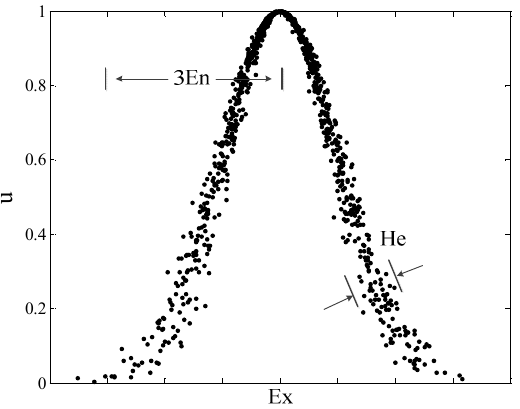
Figure 7. Three digital characteristics of a normal cloud model. u is membership factor.